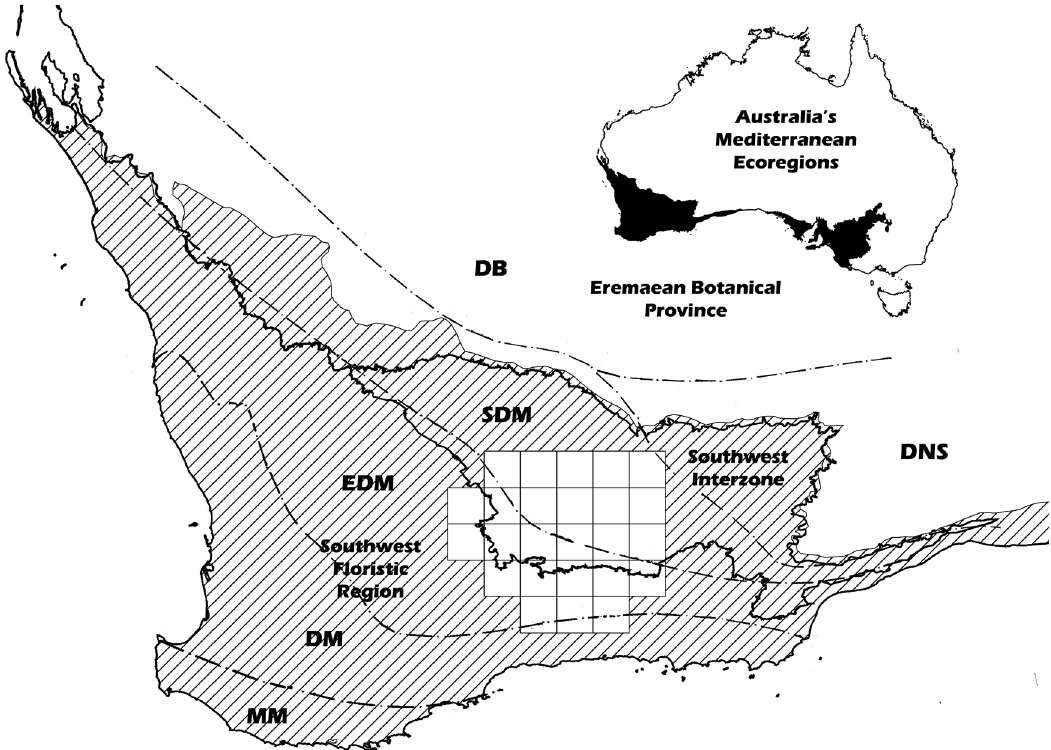
Fig. 1. The location of our study area (gridded) shown in relation to Mediterranean southwest Australia sensu Wilson et al. (2007) (hatched), the southwest Australian floristic region (Beard 1980, Hopper and Gioia 2004) and the southwest interzone (Beard 1980) (bold lines). The climate zones of Beard (1984); moderate Mediterranean (MM), dry Mediterranean (DM), extra-dry Mediterranean (EDM), semi-desert Mediterranean (SDM) desert bixeric (DB) and desert non-seasonal (DNS) are also shown (dotted